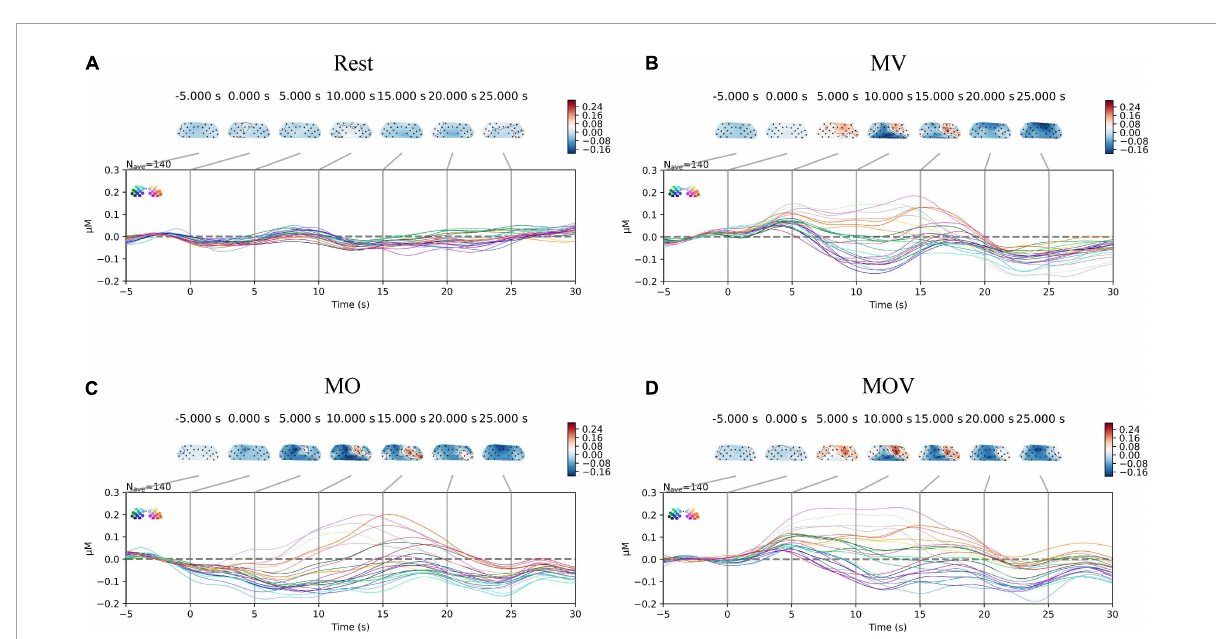
FIGURE5 Change in cortical oxyhemoglobin (HbO) amplitude. The subplots (A–D) correspond to the changes in activation of the sensorimotor brain regions under the four task conditions of Rest, MV, MO, and MOV, respectively. The upper part of each subplot shows the changes in the topological HbO content. The topogram of the left part of the brain is the C3 brain region, and the right part is the C4 brain region. The different colors of the brain topogram correspond to the different values of HbO content, which correspond to the color bar on the right (unit is µ Mol/L). The lower part of each subplot shows the HbO data curve for each channel in µ Mol/L for a total of 24 channels. The data curves for each of the 24 channels are in µ Mol/L, with different colored data lines corresponding to different positions of the channels.